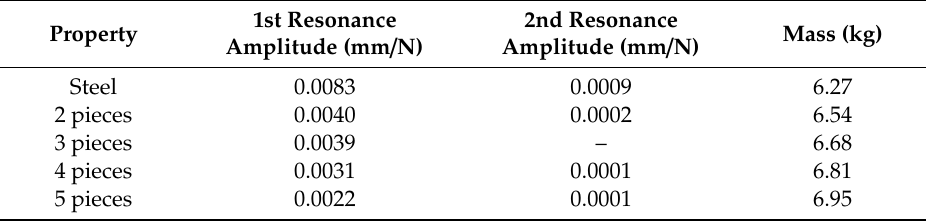
Table 5. Receptance function amplitudes for the first two resonances for partially covered